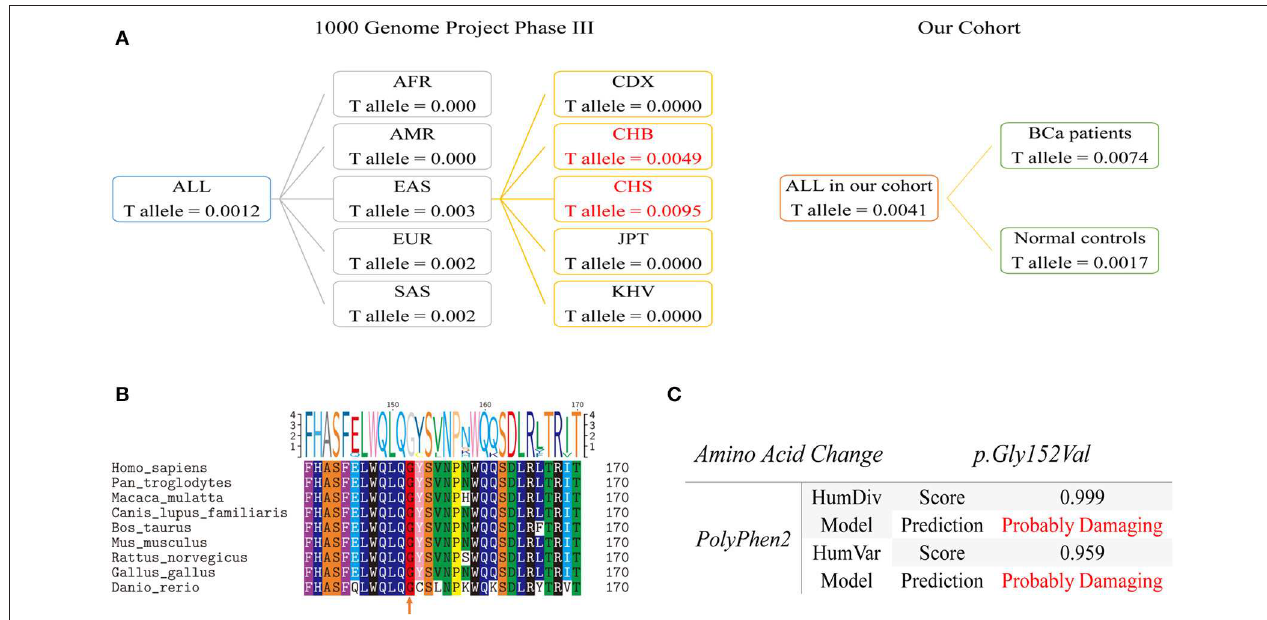
FIGURE 3 | Population genetic comparison, evolutionary conservation analysis and functional prediction. (A) Left Panel: T allele frequency of rs35356162 in the 1000 Genomes Project. Frequencies of mainland Han Chinese subgroup are highlighted in red. Right Panel: the T allele frequency of rs35356162 in the present study, shown separately by bladder cancer cases and controls. (B) UHRF1BP1 p.Gly152 amino acid conservation analysis across species assessed with multiple sequences alignment. The orange arrow indicated the amino acid position which rs35356162 may alter. (C) In silico predicted effects of p.Gly152Val variant, assessed with PolyPhen2, by HumDiv and HumVar models. HumDiv model is a preferred model for evaluating rare alleles and dense mapping of regions identified by GWAS. HumVar model is a preferred model for diagnostics of Mendelian diseases which requires distinguishing mutations with drastic effects from all the remaining human variation, including abundant mildly deleterious alleles. In this study, HumDiv model is preferred, but we also presented result from HumVar model as a reference. population (0.0097) were much higher than that detected in